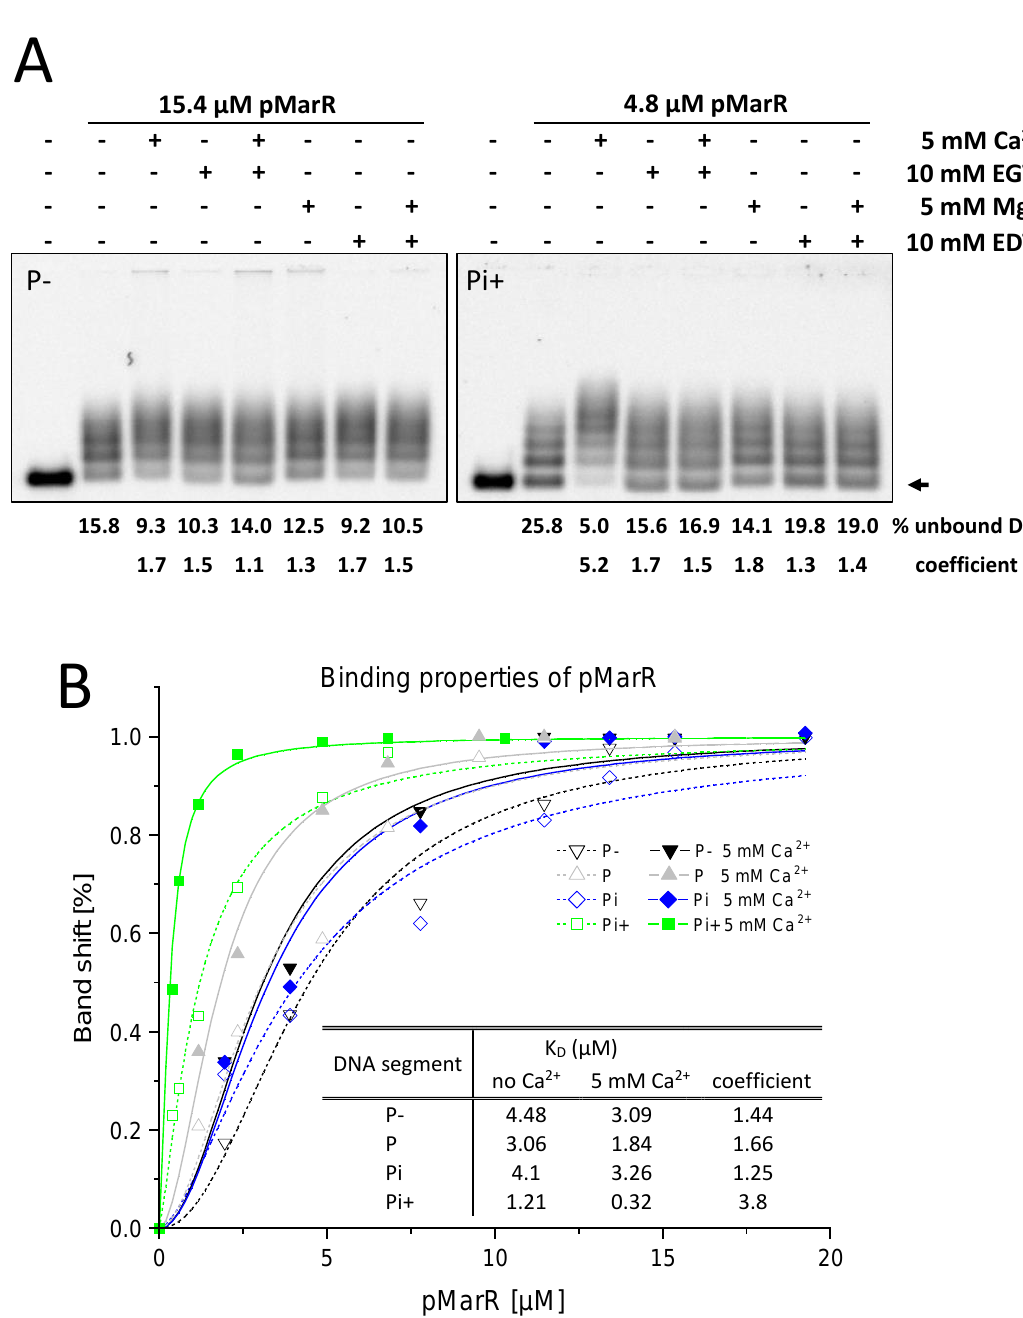
Figure 2. DNA-binding properties of purified recombinant pMarR protein. ( A ) pMarR DNA binding was tested by EMSA using Cy5-labeled rne P − and Pi+ DNA segments. Binding reactions contained